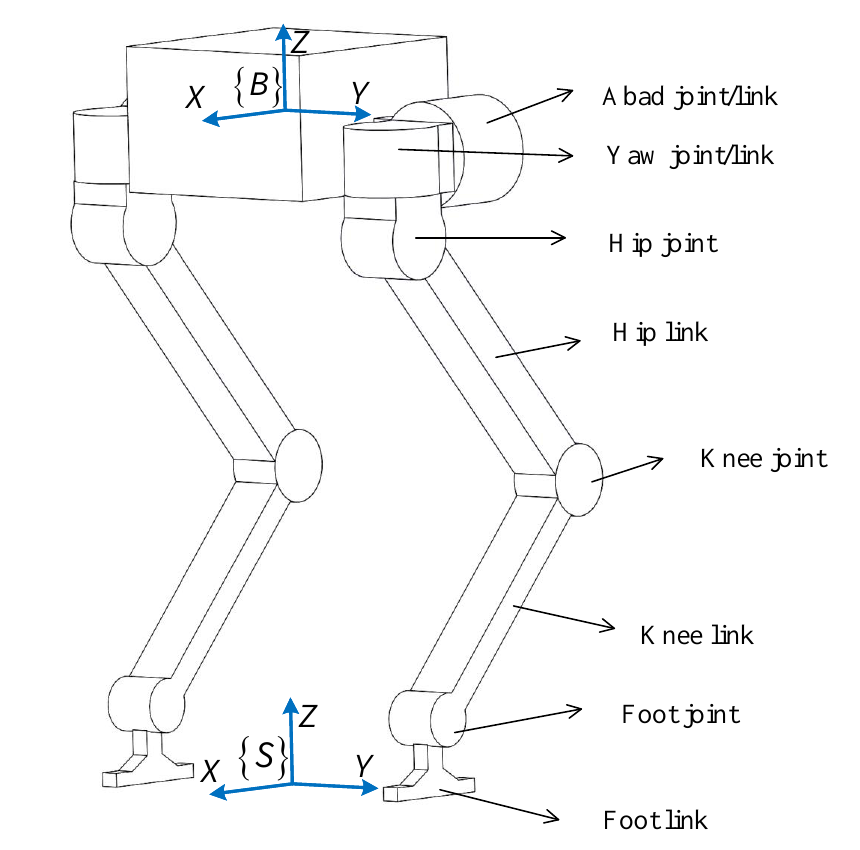
Figure 2. The structure of the biped robot. { B } is the body frame, { S } is the inertia